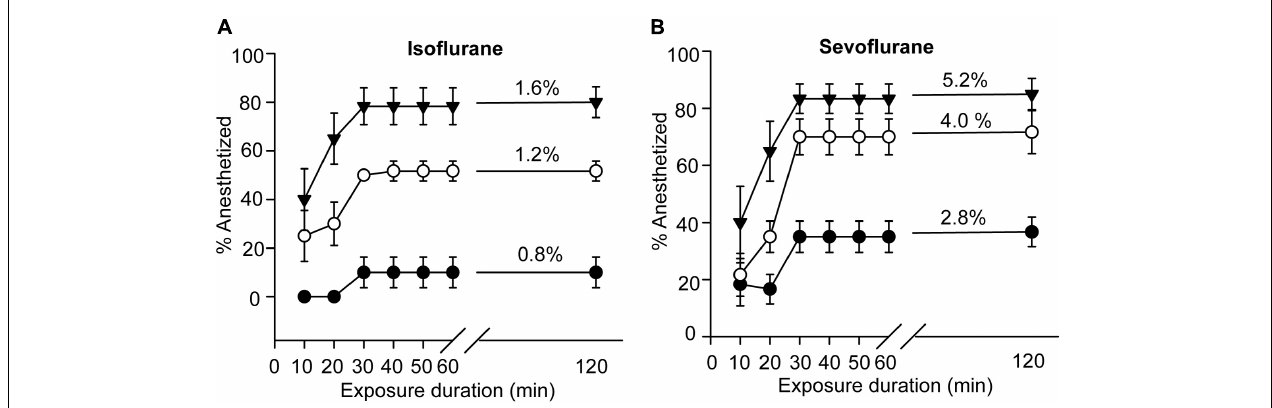
FIGURE 1 | Anesthesia effects of isoflurane and sevoflurane on the migratory locusts. (A) Anesthetic response of the migratory locusts to isoflurane (0.8%, 1.2%, and 1.6%, n = 60 for each time point) after 120-min exposure interval. (B) Anesthetic response of the migratory locusts to sevoflurane (2.8%, 4.0%, and 5.2%, n = 60 for each time point) after 120-min exposure interval. One-way ANOVA analysis is used for analyzing anesthetic effect. The percentage of anesthetized locusts is shown as the mean ± SEM.